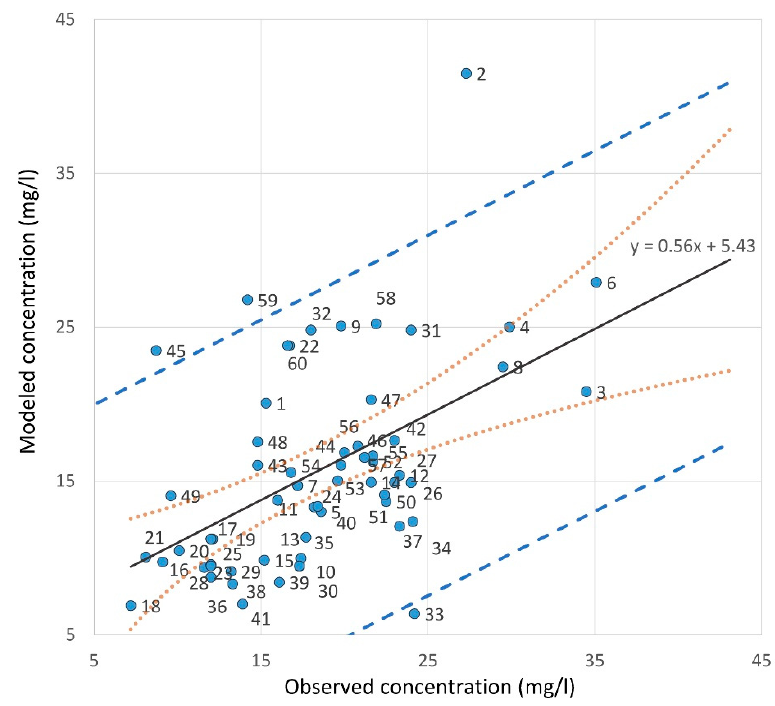
Figure 11. Scatterplot of observed and modeled nitrate concentrations at the observation locations, with fitted line (black line), 95% confidence band (light-brown dotted line), and 95% prediction band (blue dashed line).